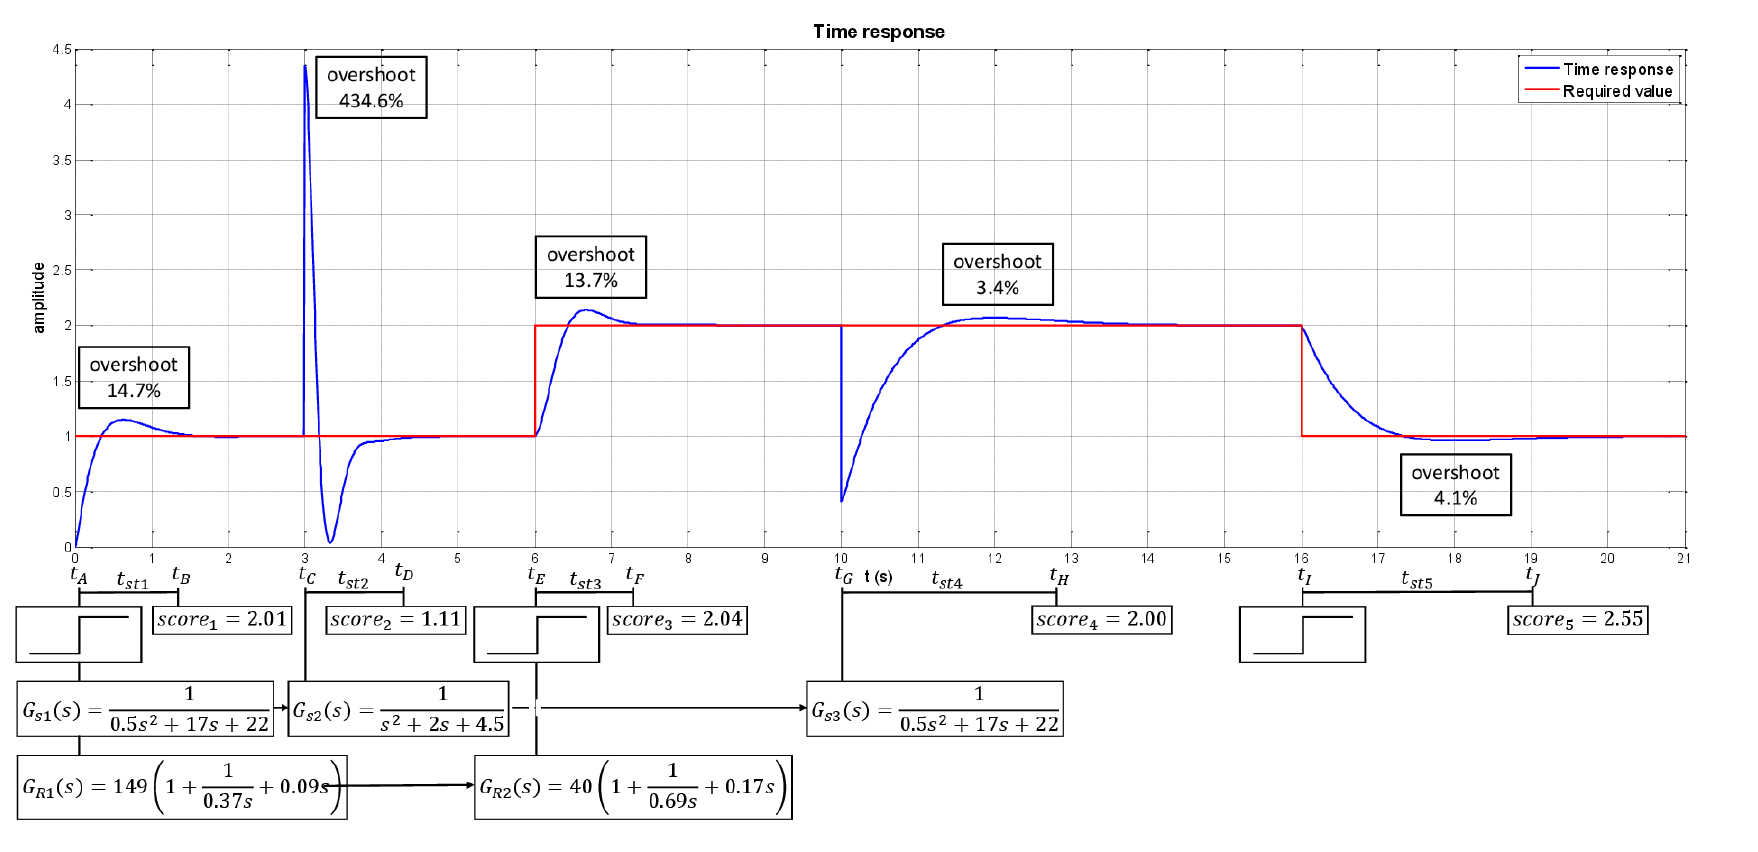
Figure 17. Time course of the simulation of the intelligent controller